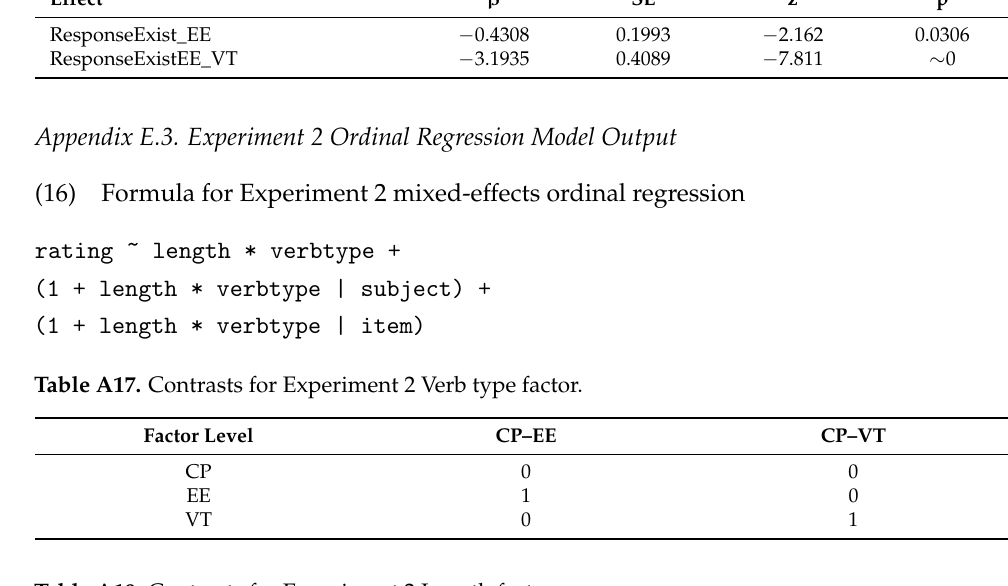
Table A18. Contrasts for Experiment 2 Length